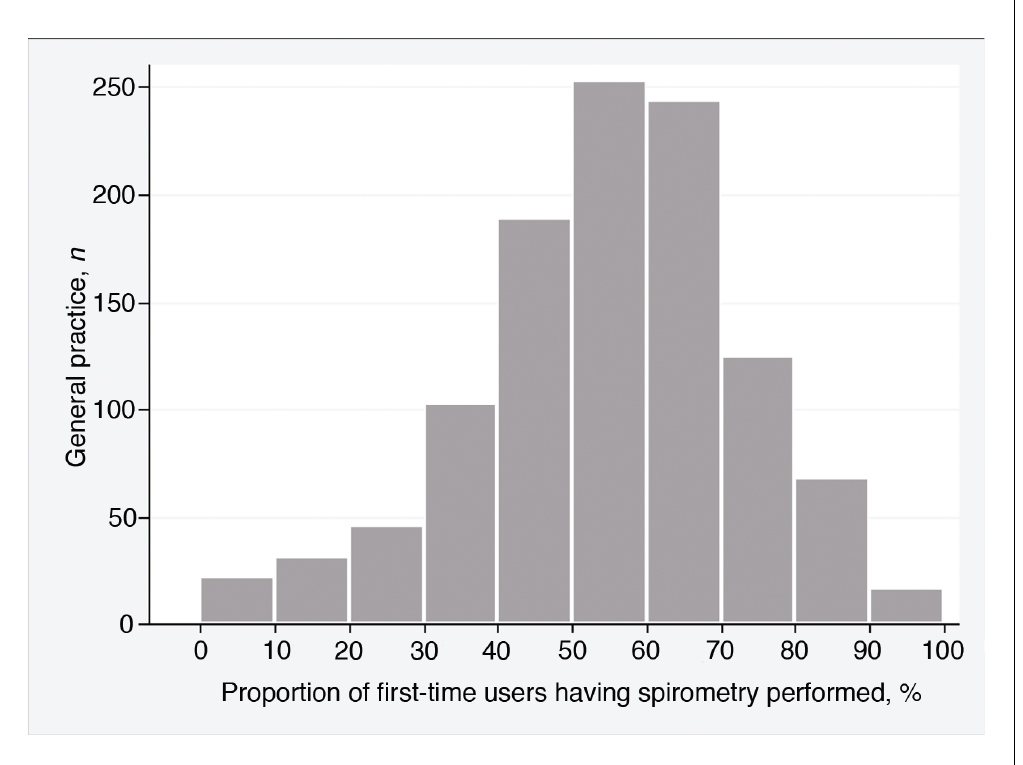
Figure 2. Variation in spirometry proportion among general